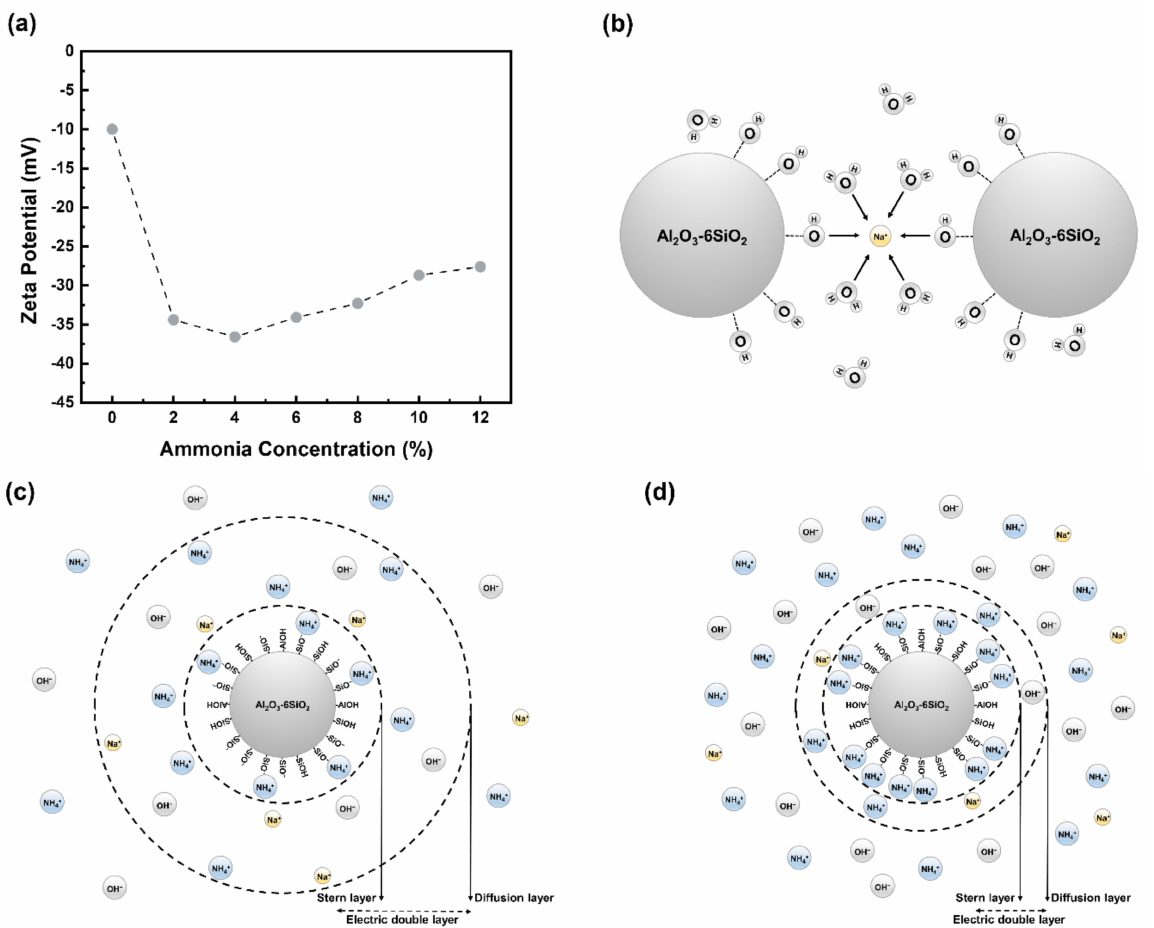
Figure 5. ( a ) Zeta potential value of aluminum silicate in a solution with different ammonia contents, schematic picture of ( b ) aggregation behavior with the particle of AS-0 powder, change in the thickness of the electrical double layer when ( c ) the content of ammonium ions is low, and ( d ) the content of ammonium ions is